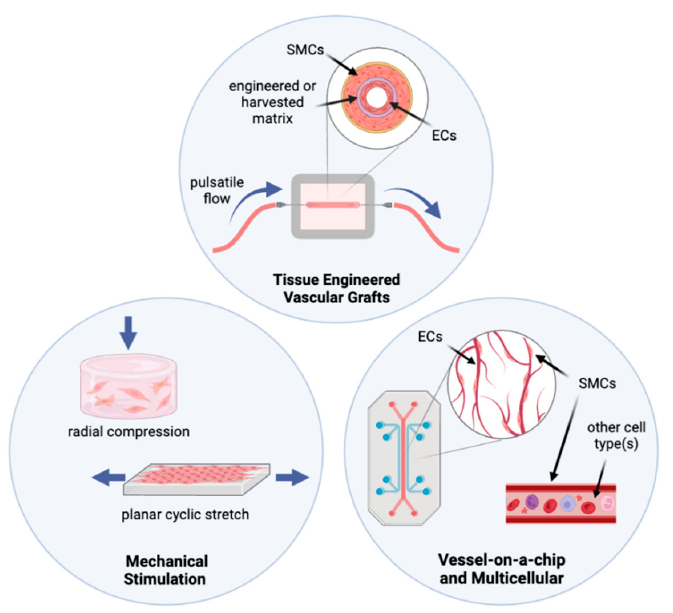
Figure 2. Schematic illustration of smooth muscle tissue engineering approaches. ( top ) Tissue Engineered Vascular Grafts, ( left ) Mechanical Stimulation Systems, and ( right ) Vessel-on-a-chip and multicellular culture systems. Created with BioRender.com.